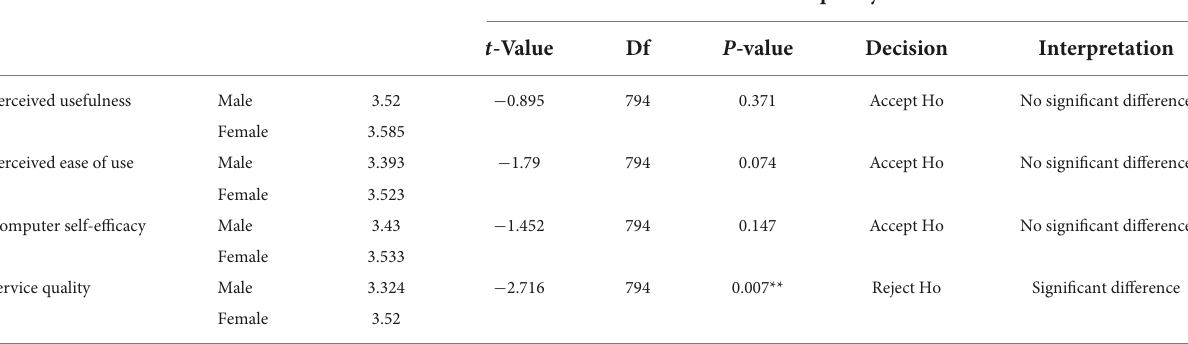
TABLE 3 Differences in the factors influencing the blended learning of computer science college students in terms of gender. Indicators